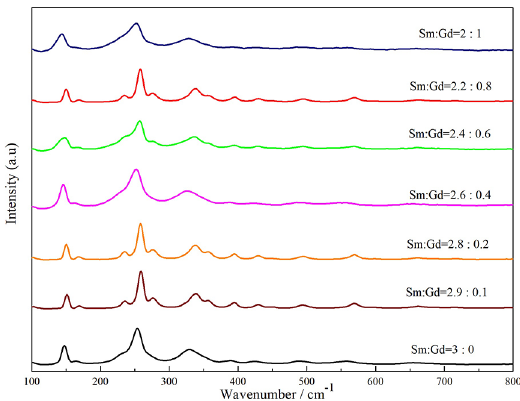
Gd Fe O with 3−x x 5 12 Figure 14. Amplified region Raman spectrum of the garnet-system